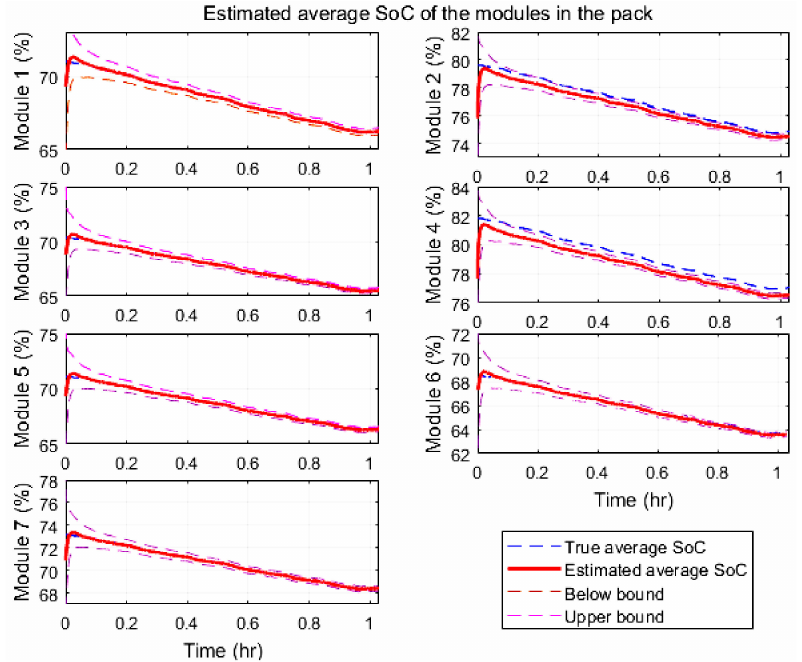
Figure 10. The average SoC of the cell modules in the LiBP.